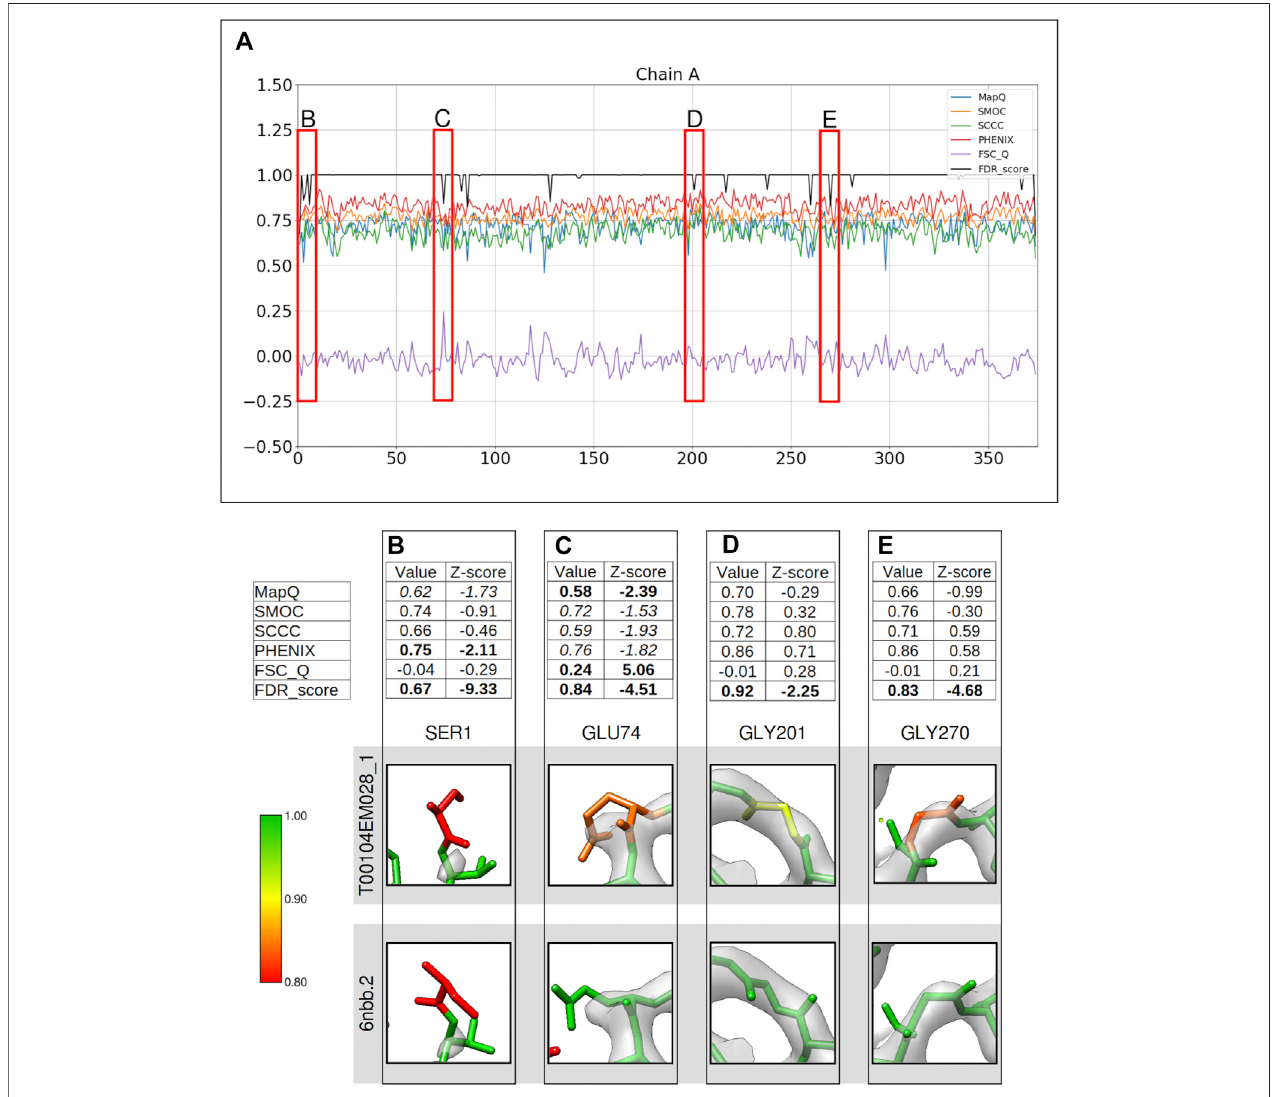
FIGURE2| Comparisonofmetricsfortheatomicmodelofalcoholdehydrogenase(colorbarshowsthecorrespondencewiththeFDRscoresassigned,residuesin redhaveFDRscoresaround0.8orworse,yellowaround0.9,andgreenaround1.0).Themetricsarecalculatedonlyforthebackboneatoms. (A) Per-residueplotofthe scores from MapQ, SMOC, SCCC, PHENIX, FSC-Q, and FDR backbone score for the chain A of the atomic model T0104EM028_1 from the EMDB model; the red boxes highlight the residues selected for detailed analysis in the panels below. For Ser1 (B) , Glu 74 (C) , Gly 201 (D), and Gly 270 (E) , the panel shows a table with valuesofscoresobtainedwitheach metricand corresponding Z-scores; theresidue fi tinthetarget map (EMD-0406, grey)displayed atthe recommendedcontour level and rendered in UCSF Chimera; and the residue fi t in map as modeled in the reference (PDB ID: 6nbb.2).